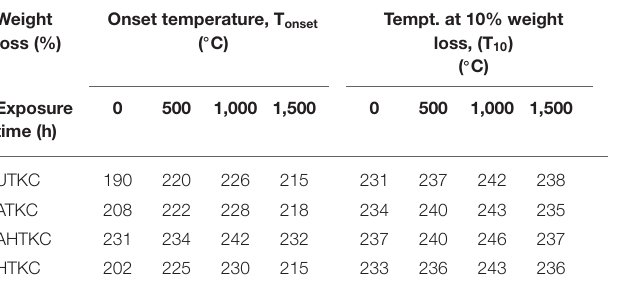
TABLE 4 | Thermal properties of composites with respect to exposure time of accelerated weathering test.